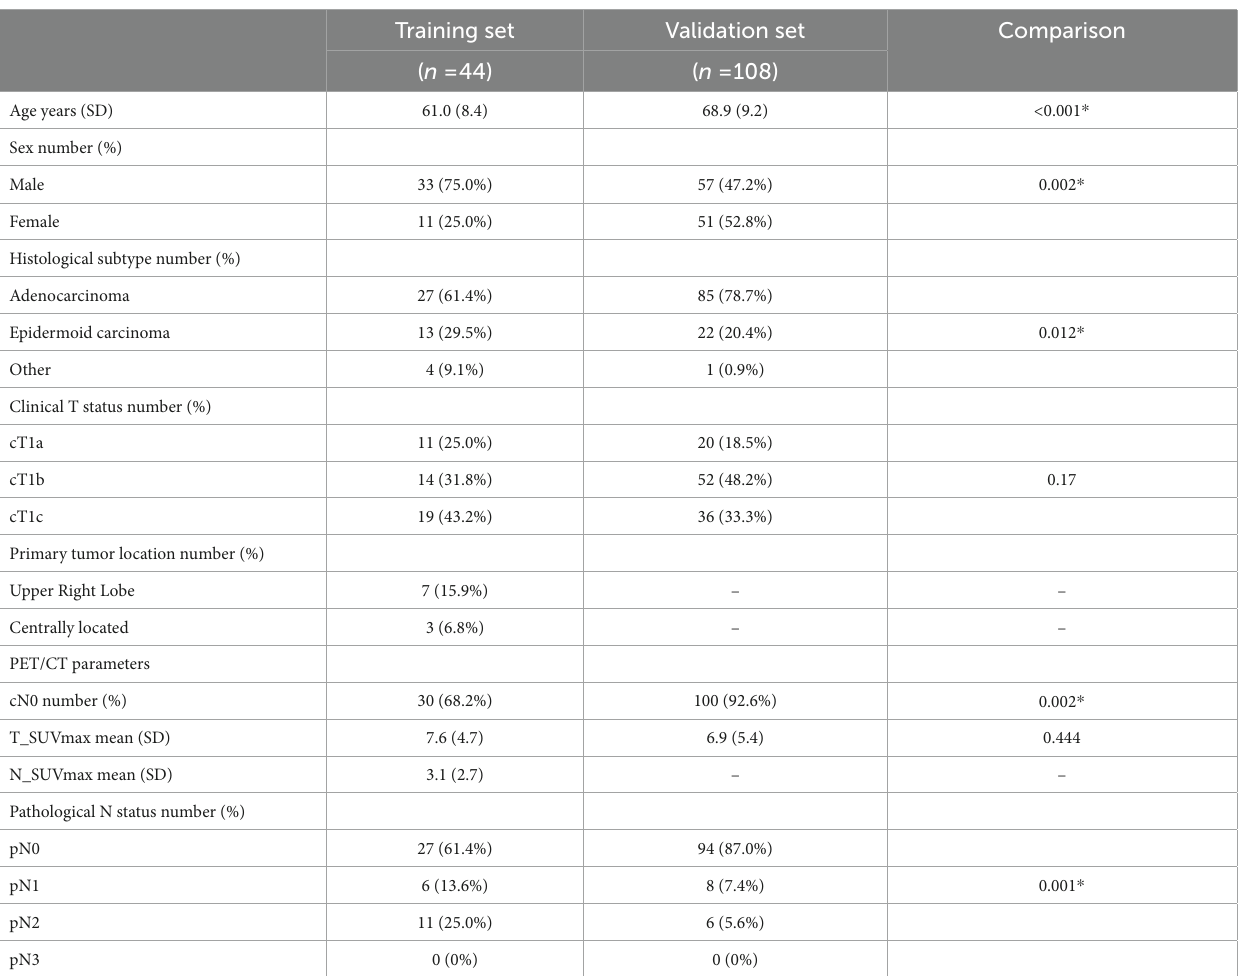
TABLE 1 Patients’ characteristics.